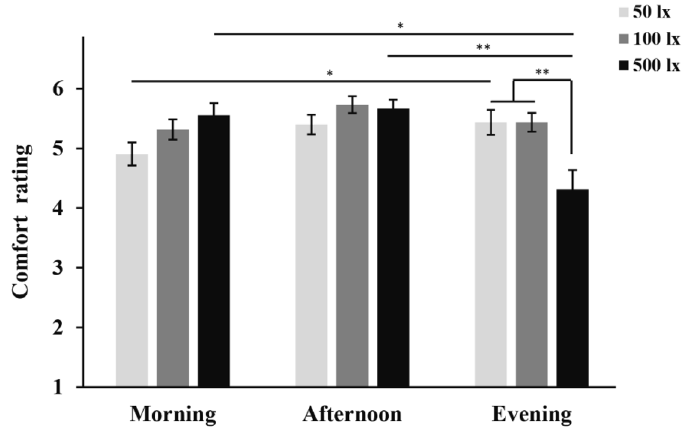
Figure 2. Pairwise comparisons among comfort ratings under different illuminance levels and time-of-day. * p < 0.05; ** p < 0.01.